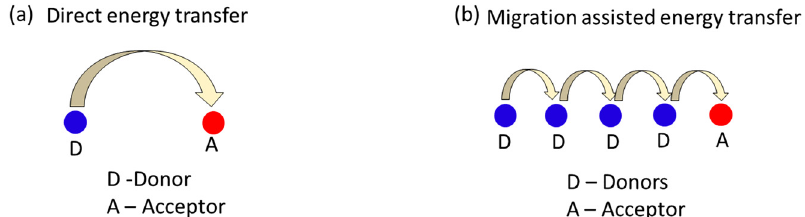
Figure 3: Schematics of direct (a) and migration-assisted (b) energy